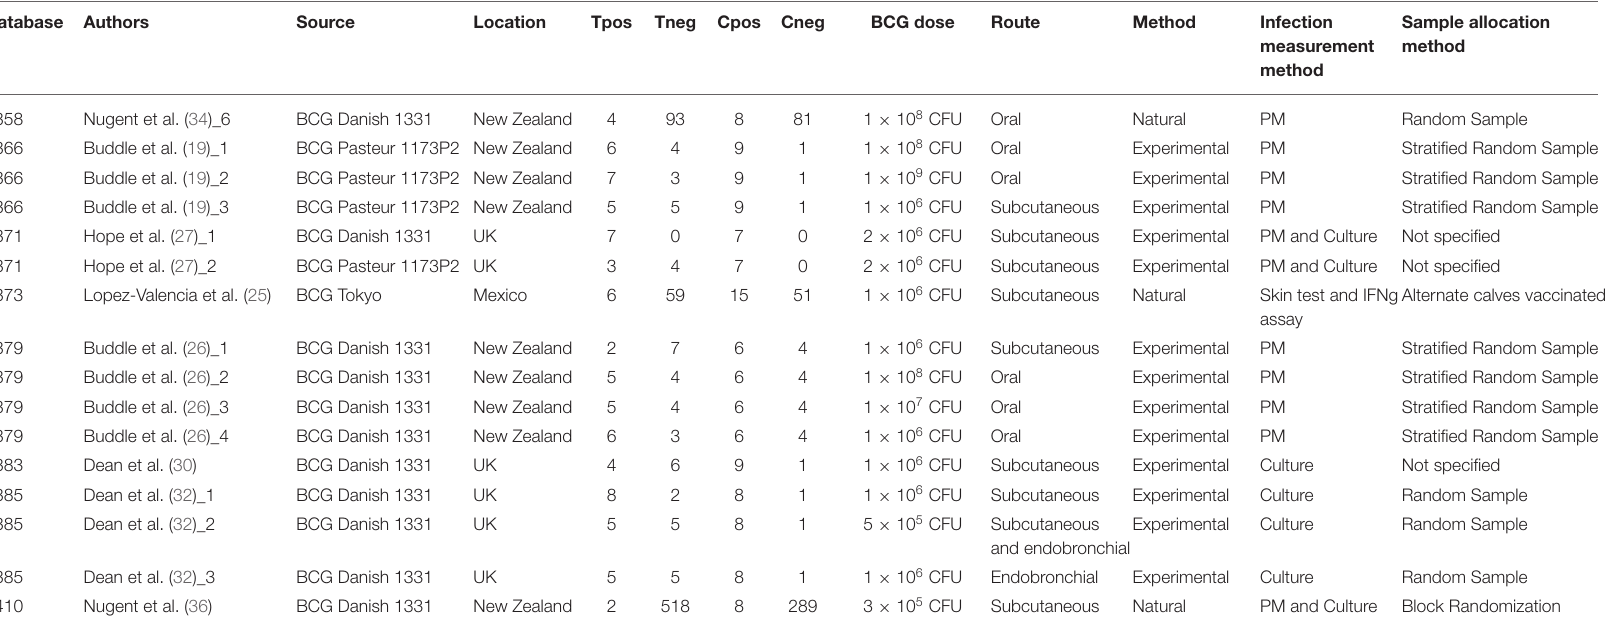
* Buddle et al. (21)_3 used a combination of Oral and Subcutaneous BCG; Study no. 1263 (24) was performed in buffaloes. Tpos and Cpos are animals classified as positive for bTB in vaccinates and controls, respectively. Tneg and Cneg are animals that remained negative for bTB in vaccinates and controls,